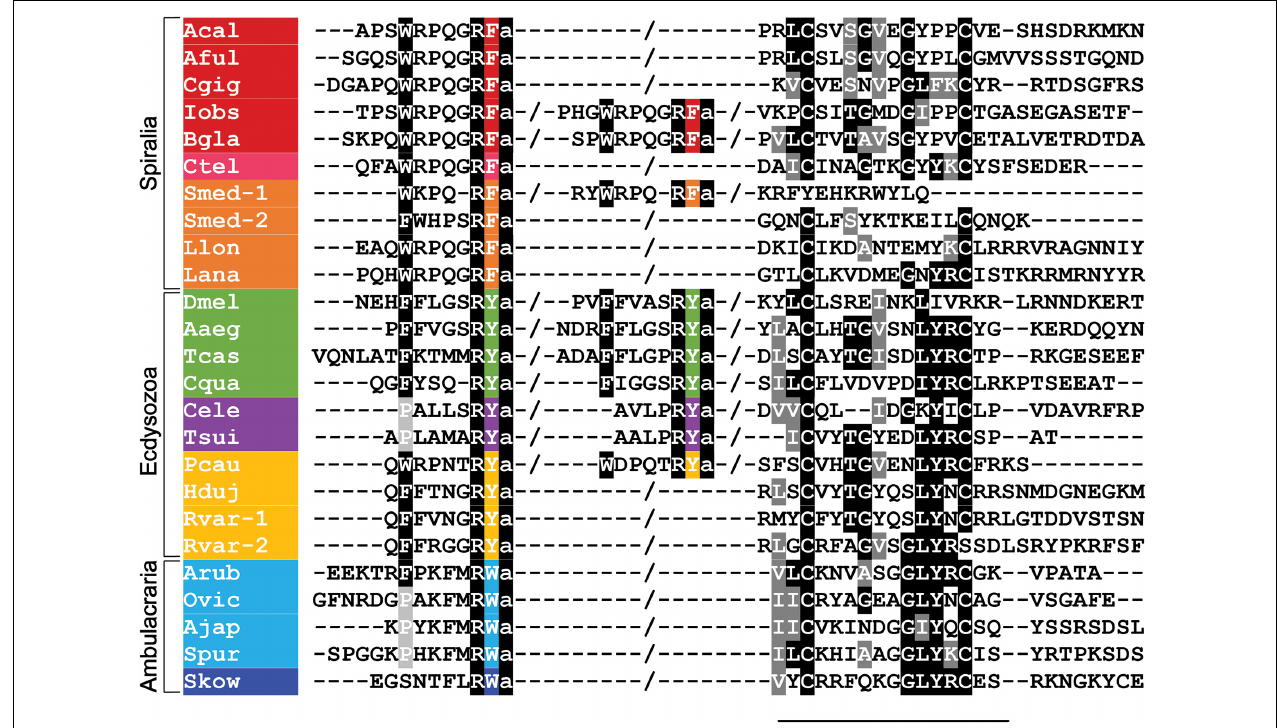
FIGURE 1 | Alignment of the N-terminal neuropeptide-containing and C-terminal regions of luqin-type precursor proteins in bilaterians. Conserved residues are highlighted in black or gray. The C-terminal residues of the luqin-type neuropeptides and species names are highlighted in phylum-specific colors: red (Mollusca), pink (Annelida), orange (Platyhelminthes, Brachiopods, and Nemerteans), green (Arthropoda), purple (Nematoda), yellow (Priapulida and Tardigrada), light blue (Echinodermata), and dark blue (Hemichordata). Species names are as follows: Acal ( Aplysia californica ), Aful ( Achatina fulica ), Cgig ( Crassostrea gigas ), Iobs ( Ilyanasa obsoleta ), Bgla ( Biomphalaria glabrata ), Ctel ( Capitella teleta ), Smed ( Schmidtea mediterranea ), Lana ( Lingula anatina ), Llon ( Lineus longissimus), Dmel ( Drosophila melanogaster ), Aaeg ( Aedes aegypti ), Tcas ( Tribolium castaneum ), Cqua ( Cherax quadricarinatus ) Tsui ( Trichuris suis ), Cele ( Caenorhabditis elegans ), Pcau (Priapulus caudatus), Hduj ( Hypsibius dujardini ), Rvar ( Ramazzottius varieornatus ), Arub ( Asterias rubens ), Ovic ( Ophionotus victoriae ), Ajap ( Apostichopus japonicus ), Spur ( Strongylocentrotus purpuratus ), Skow ( Saccoglossus kowalevskii ). The sequences used for this alignment were reported in Koziol et al. (2016); Koziol (2018), Yañez-Guerra et al. (2018), and De Oliveira et al.